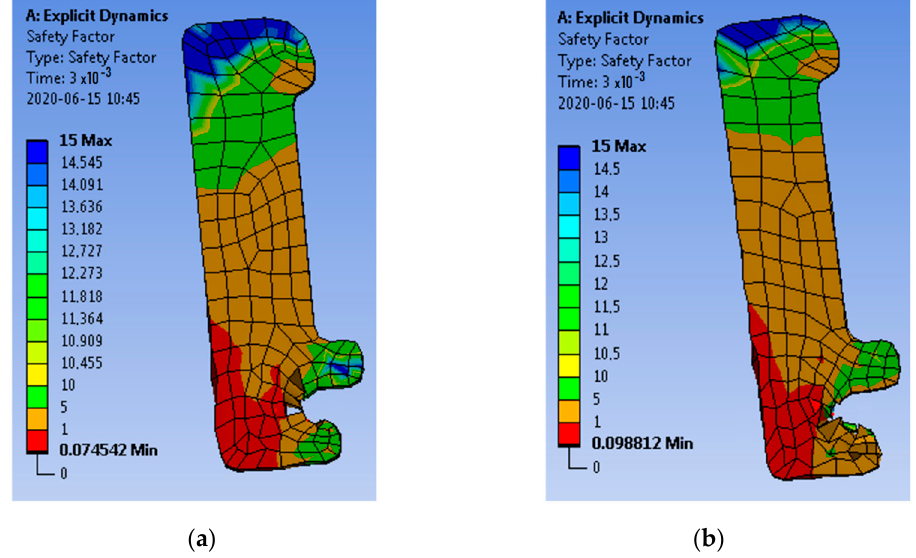
Figure 17. View of small lamellas: ( a ) Old lamellar radius R6—Variant I and ( b ) new lamellar radius R4—Variant II.